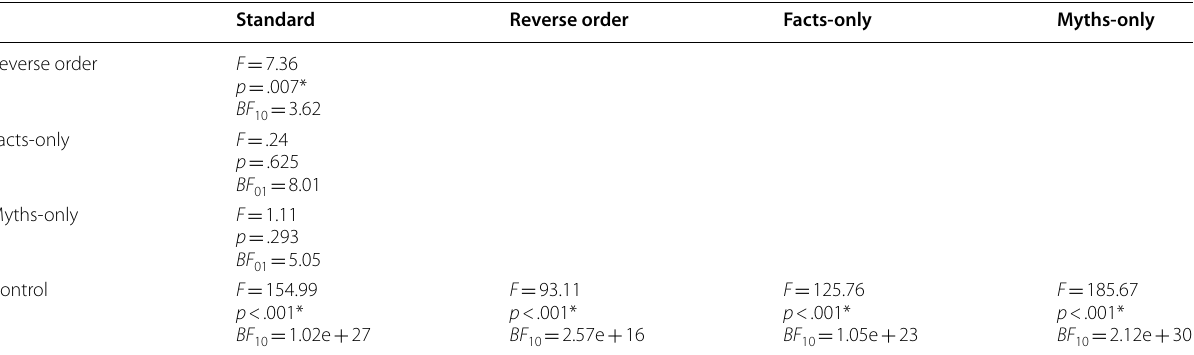
Table 5 Planned comparisons on myth belief ratings in Experiment 4